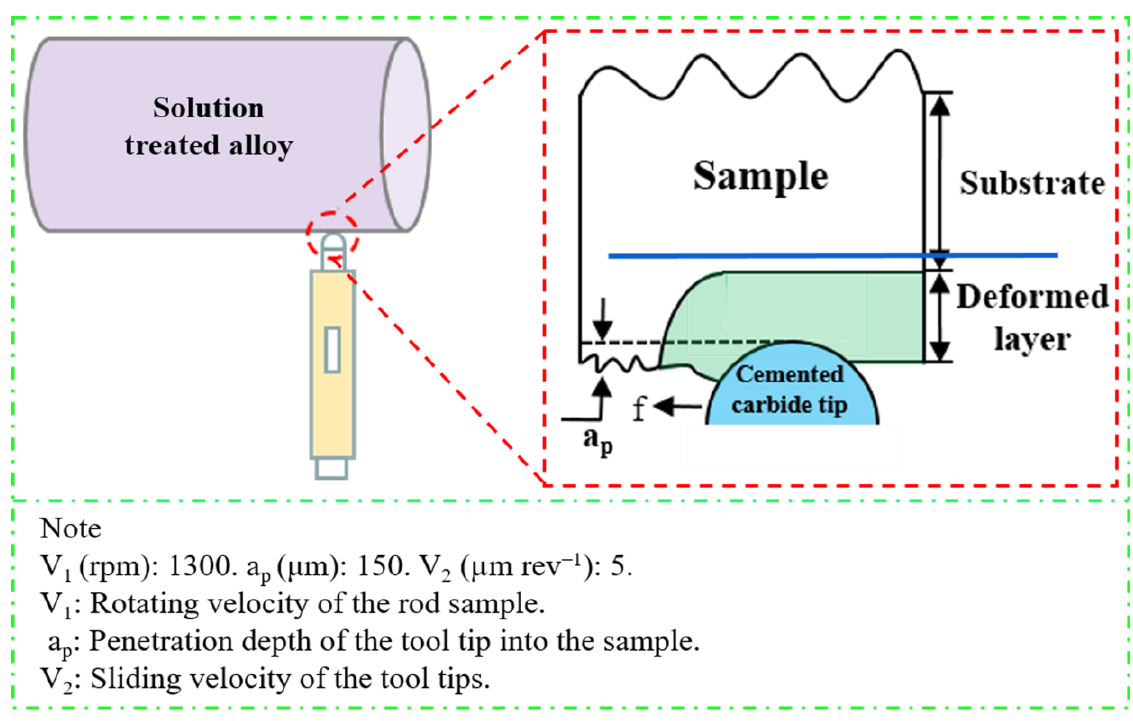
Figure 1. Schematic of the SMGT.